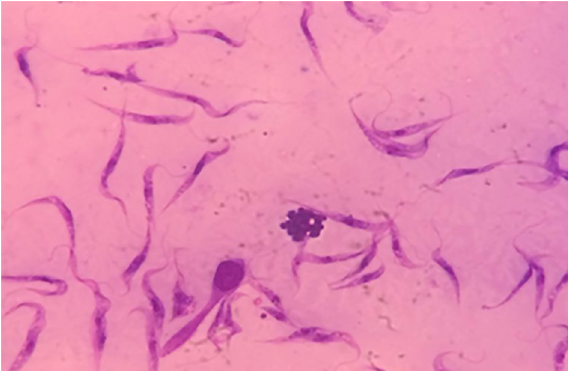
Figure 2. Epimastigote evolutionary forms of Trypanosoma rhipicephalis on tick hemolymph smear